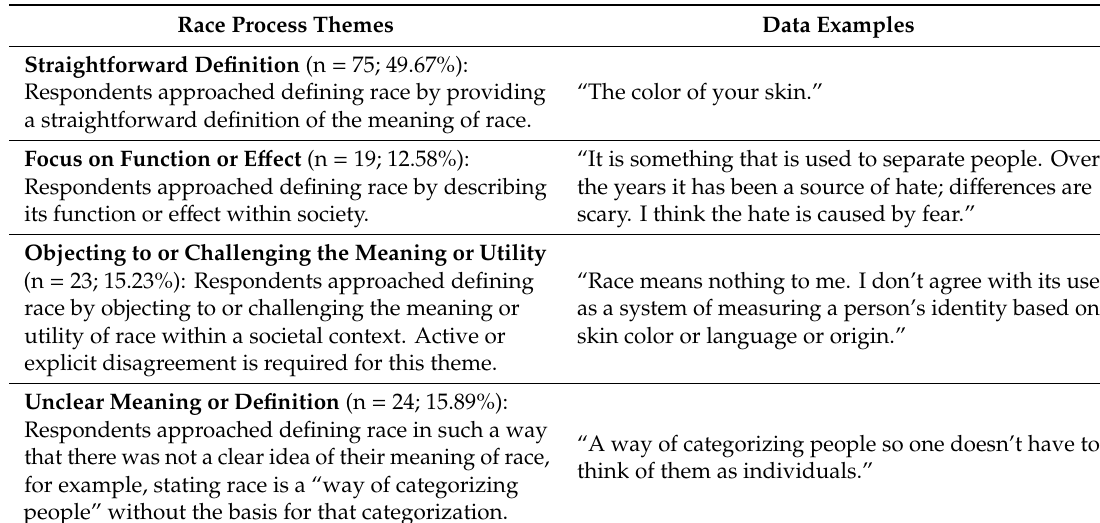
Table 4. Participants’ process approaches to generating meanings of